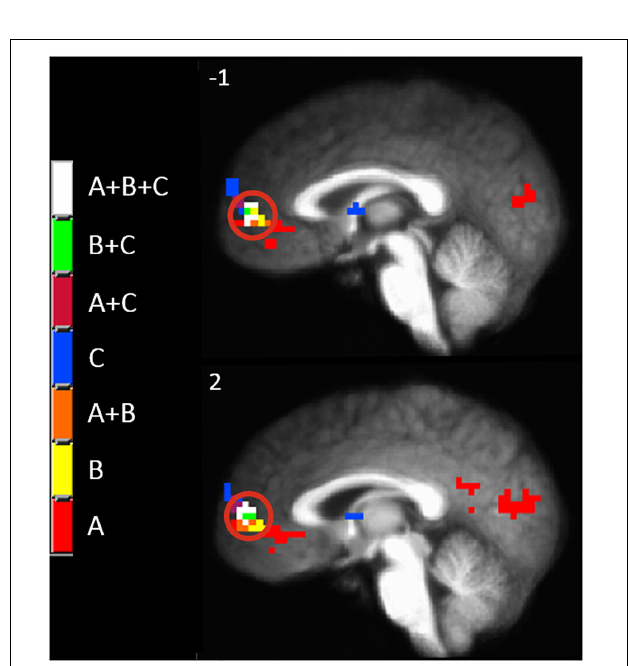
FIGURE 6 | The MPFC, indicated by the red circle, was the only region specifically modulated by anodal tDCS and the C-HP model. The functional anatomical overlap of (A) negative activation to painful mechanical stimuli in the hyperalgesic zone after sham tDCS (B) activation to painful mechanical stimuli in hyperalgesic zone where anodal > sham tDCS, and (C) where activation to painful mechanical stimuli before capsaicin exposure is significantly greater than after exposure [cluster-extent corrected voxel-wise threshold p ≤ 0.005 (B and C) or p < 0.001 (A)].